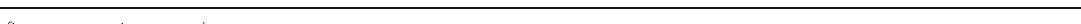
(See figure on previous page.) Fig. 3 MISTO subcategory score correlations between perspectives. Rows represent each of seven MISTO subcategories: a Active Learning Strategies, b Inclusivity, c Responsiveness to Students, d Experimental Design and Communication, e Data Analysis and Interpretation, f Cognitive Skills, g Course and Self Reflection. Columns represent correlations between (i) instructor and observer scores, (ii) student mean and observer